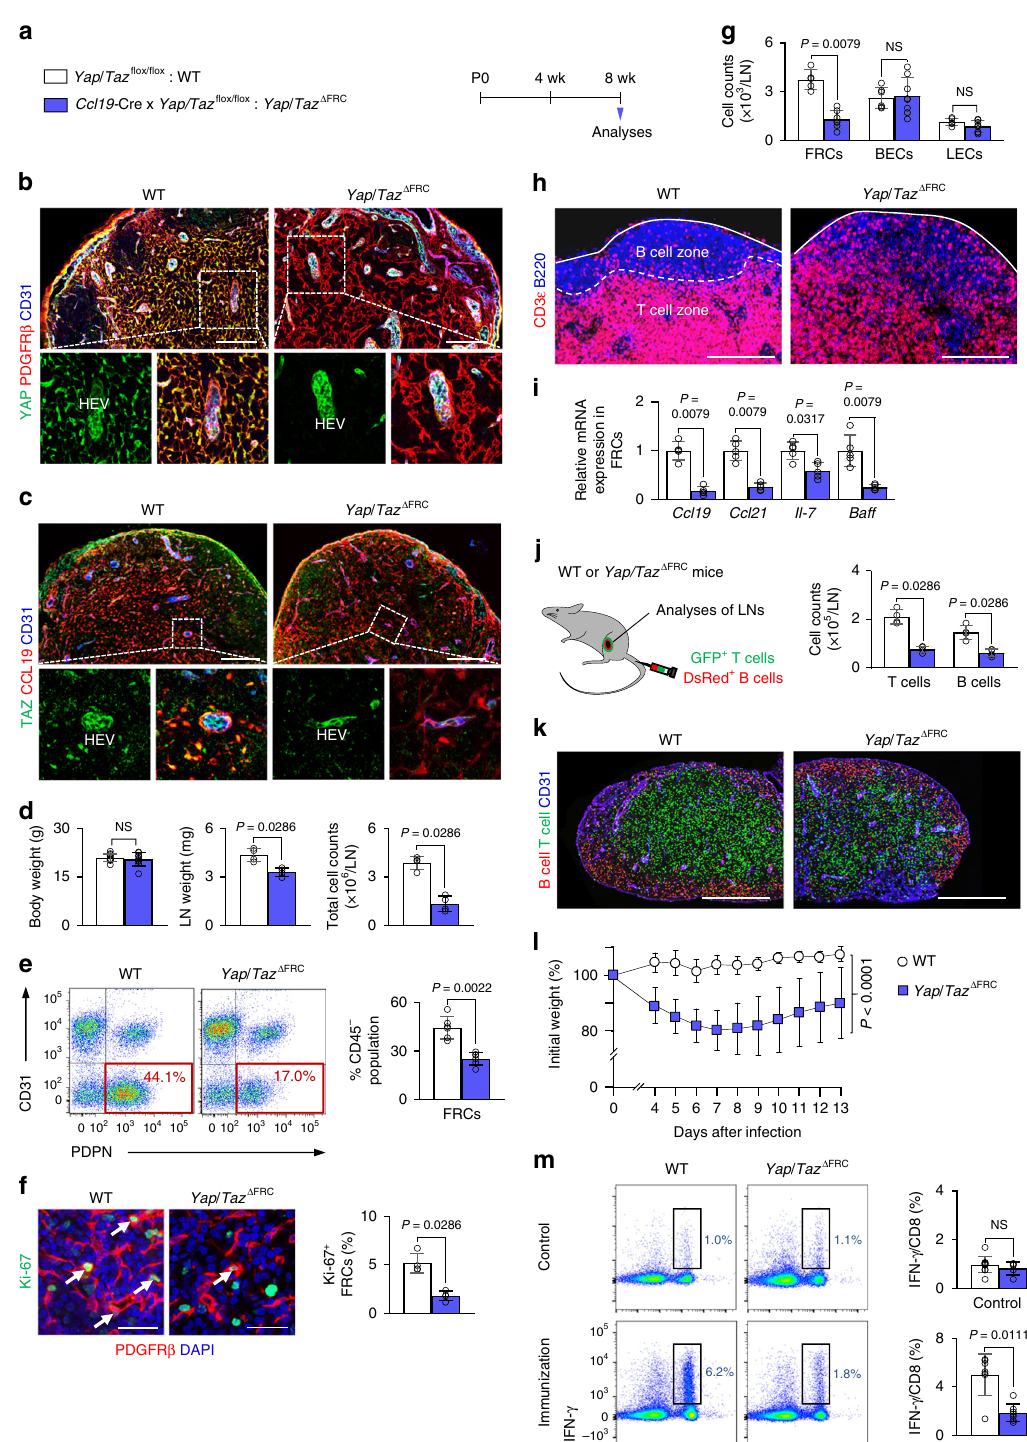
Since immune cells reorganize the reticular network after birth 3 , we examined the recruitment of lymphoid tissue inducer (LTi) cells and the organization of lymphoid tissue organizer (LTo) cells both at the embryonic and postnatal period in Lats1 / 2 Δ FRC mice (Fig. 2d). cells were observed in WT and Lats1 / 2 Δ FRC embryos (Supple-